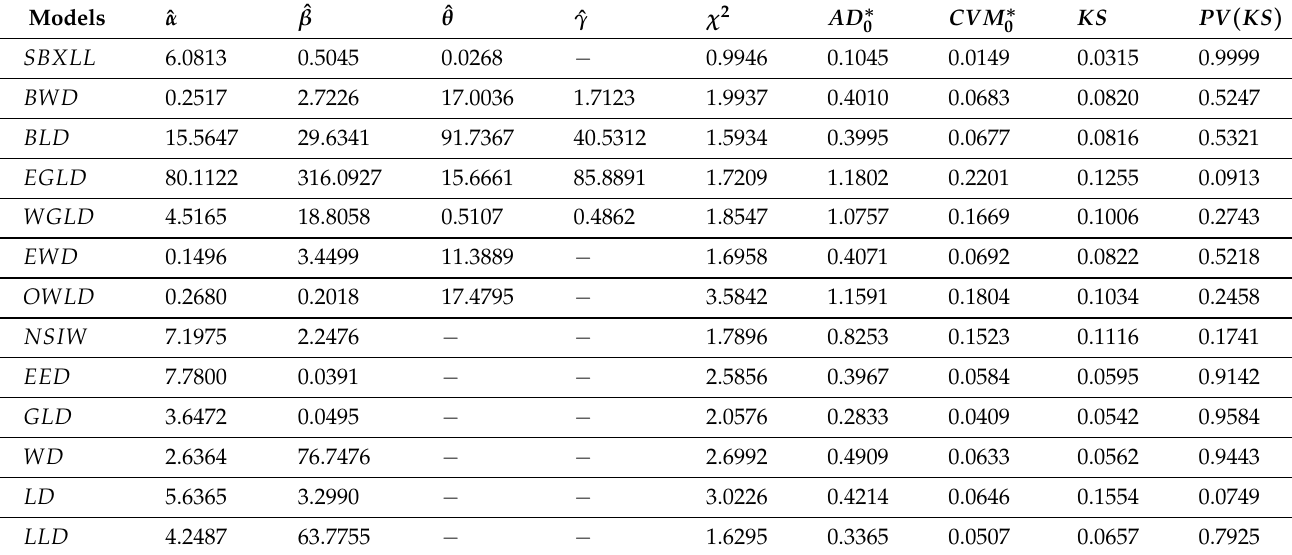
Table 17. Data set-III MLEs and goodness-of-fit.